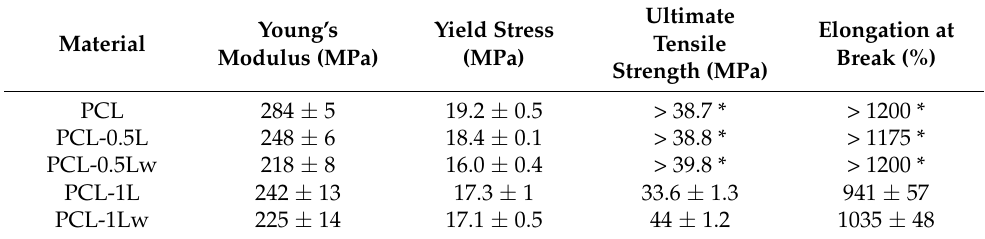
Table 4. Mechanical properties assessed from tensile tests at room temperature. Each value represents the average of 5 measurements with the standard deviation. * Data extracted at the upper limit of the instrument; break did not occur.